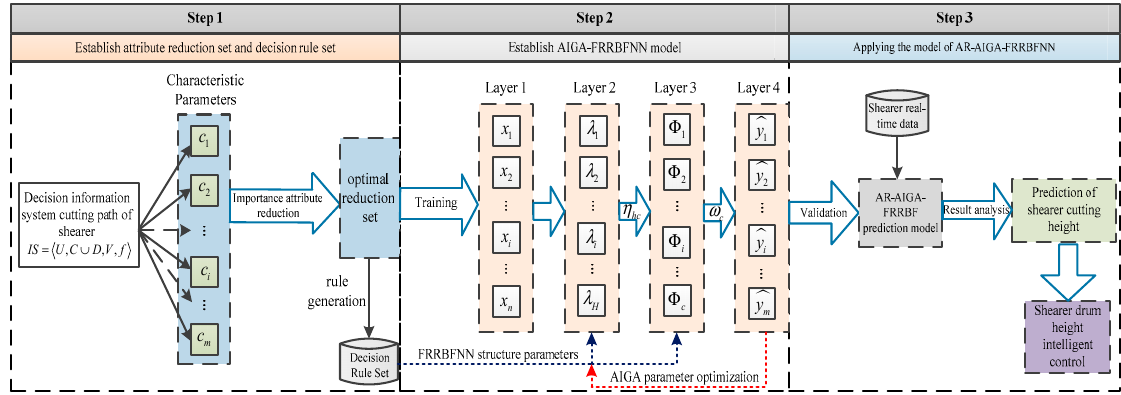
Figure 1. Steps of the proposed method.